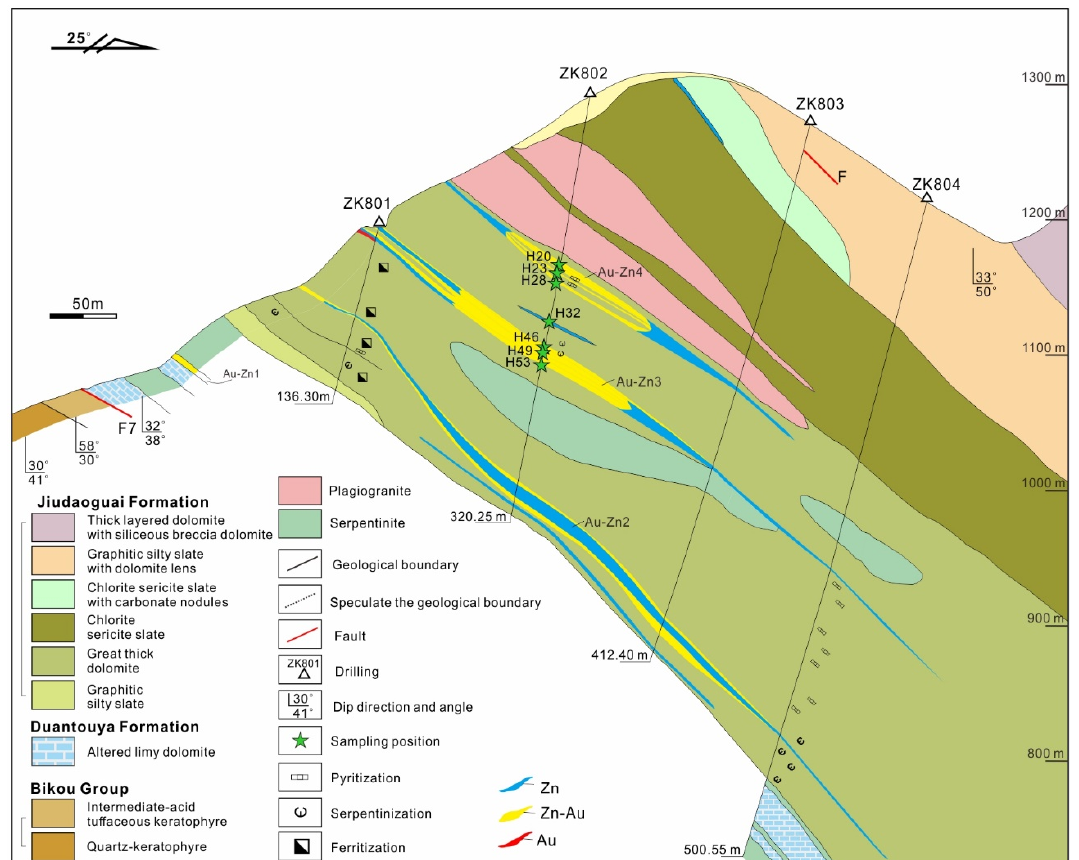
Figure 3. Prospecting line No.8 of the Liushuping Au–Zn deposit.